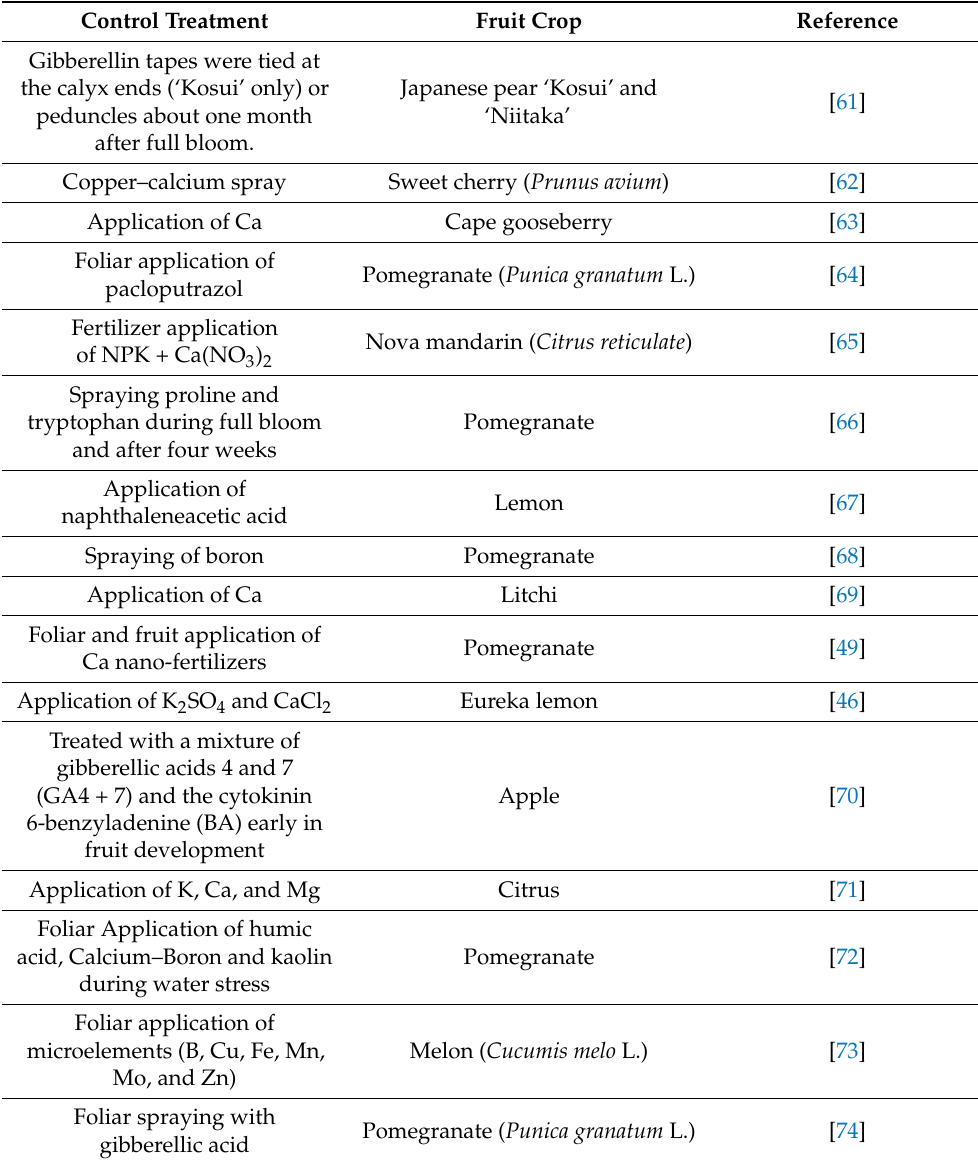
Table 1. Management of fruit cracking in different fruit